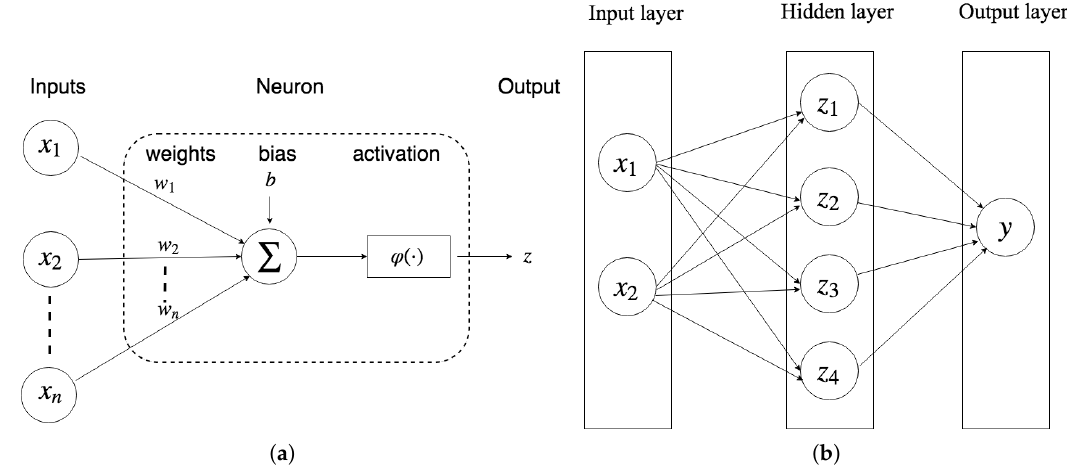
Figure 2. Illustration of a MLP configuration. ( a ) A neuron; ( b ) An example of